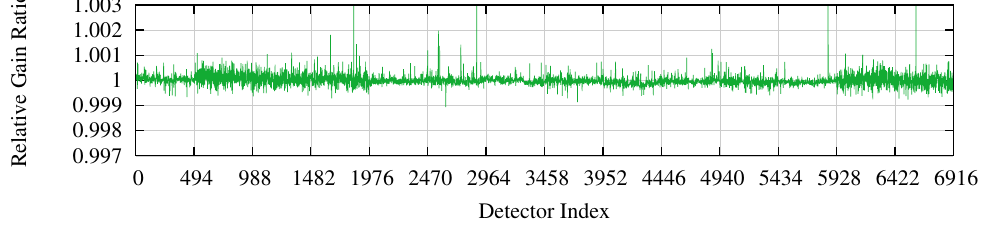
Figure 12. The ratio between the SWIR 1 solar diffuser determined relative gains for the fourth quarter of 2013 and first quarter of 2014. Individual detectors’ relative gains have jumped suddenly, which will cause single detector streaks in the imagery if left